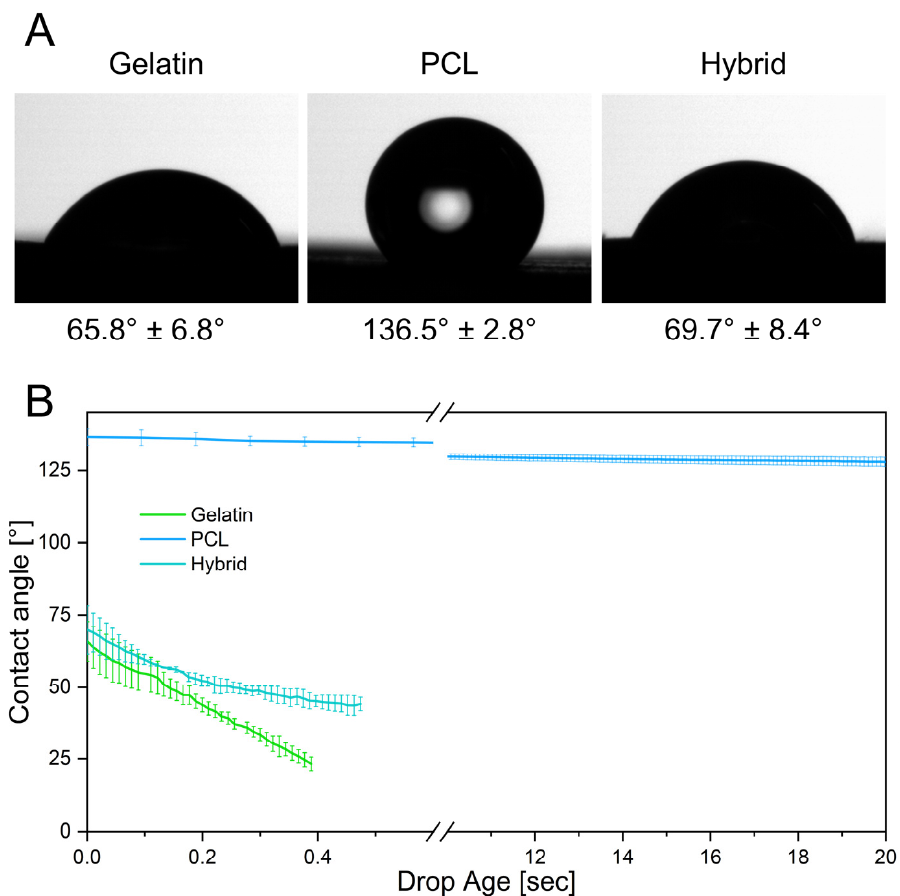
Figure 5. ( A ) Initial contact angles of gelatin, PCL, and the hybrid scaffold. ( B ) Contact angle measurements display the absorption of the water droplet into the hydrophilic scaffolds over time.